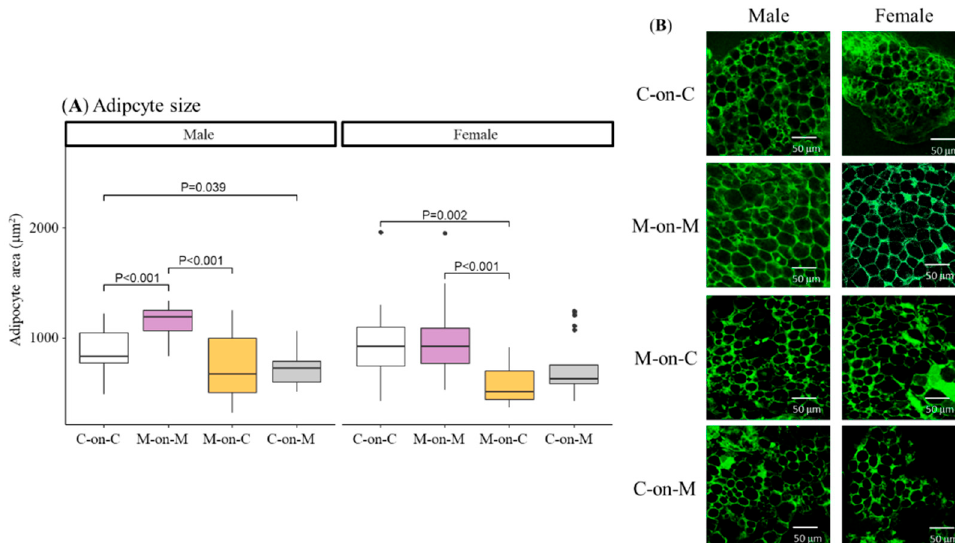
Figure 3. Average size of perivascular adipocytes ( A ) and representative images obtained by confocal microscopy ( B ) of 21-day-old male and female offspring from MUN and Control mothers. MUN, maternal undernutrition during gestation; C-on-C, control pups fostered by their mothers (6 males and 6 females); M-on-M, MUN rats fostered by their mothers (6 males and 6 females); C-on-M, control rats fostered by MUN mothers (6 males and 6 females); M-on-C, MUN rats fostered by a control mother (6 males and 6 females). Data show the median and interquartile range [Q1; Q3], and the showed p -Value (P) was extracted from Dunnett’s post-hoc pairwise comparison test when the Kruskal-Wallis test was P < 0.05. Images were acquired with a Leica TCS SP2 confocal microscope, × 40 objective at Ex = 488 nm/Em = 500–560 nm wavelength; scale bar = 50 µ m. Dots shown